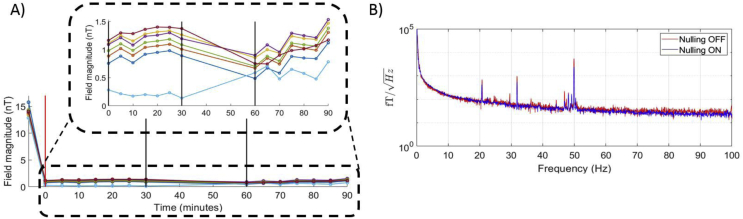
A) The static field magnitude as reported by the on-sensor coils for an array of 7 OPM sensors at 5-min intervals over a 30 min period. The red line shows when the field nulling was applied, the black lines show a period where the sensors were switched off, and the door to the MSR was left open. There followed an additional 30 min where the door was closed and further field measurements were made. The bi-planar coil currents were held constant throughout the entire 90-min experiment. B) The noise power spectra of a single OPM in this scanner-cast recorded with the field nulling OFF and ON.